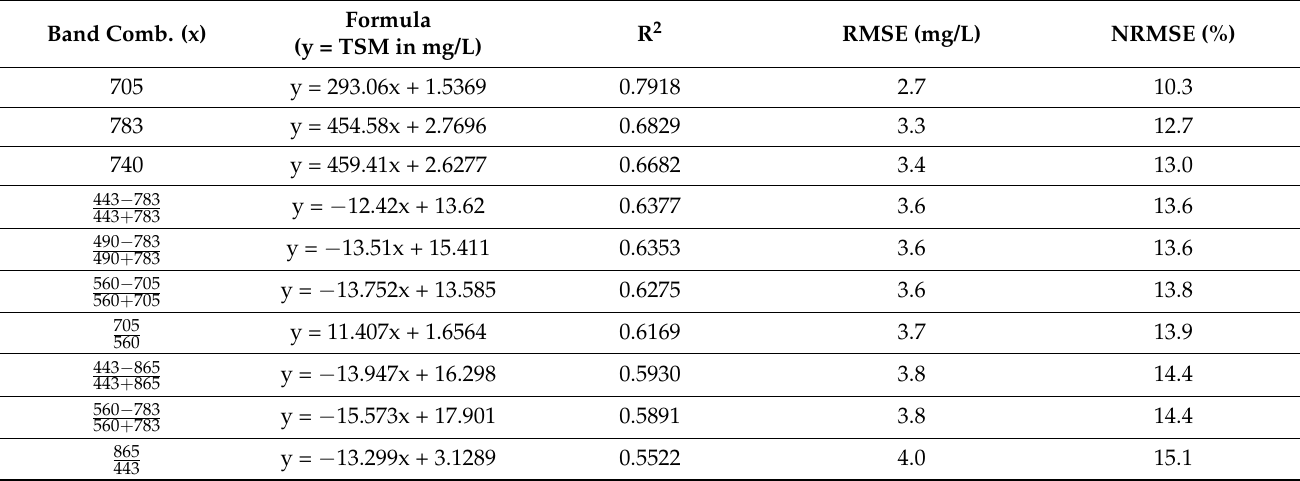
Table 2. Algorithm results for TSM. Only the best 10 results are shown. Band Comb.